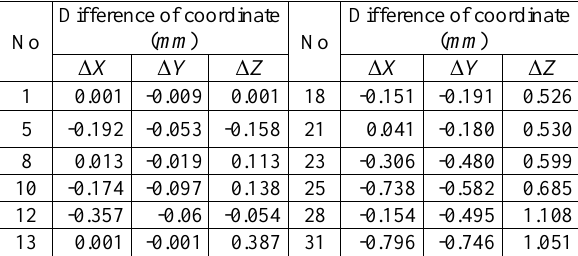
Table 3. Difference of check points object coordinates(three control